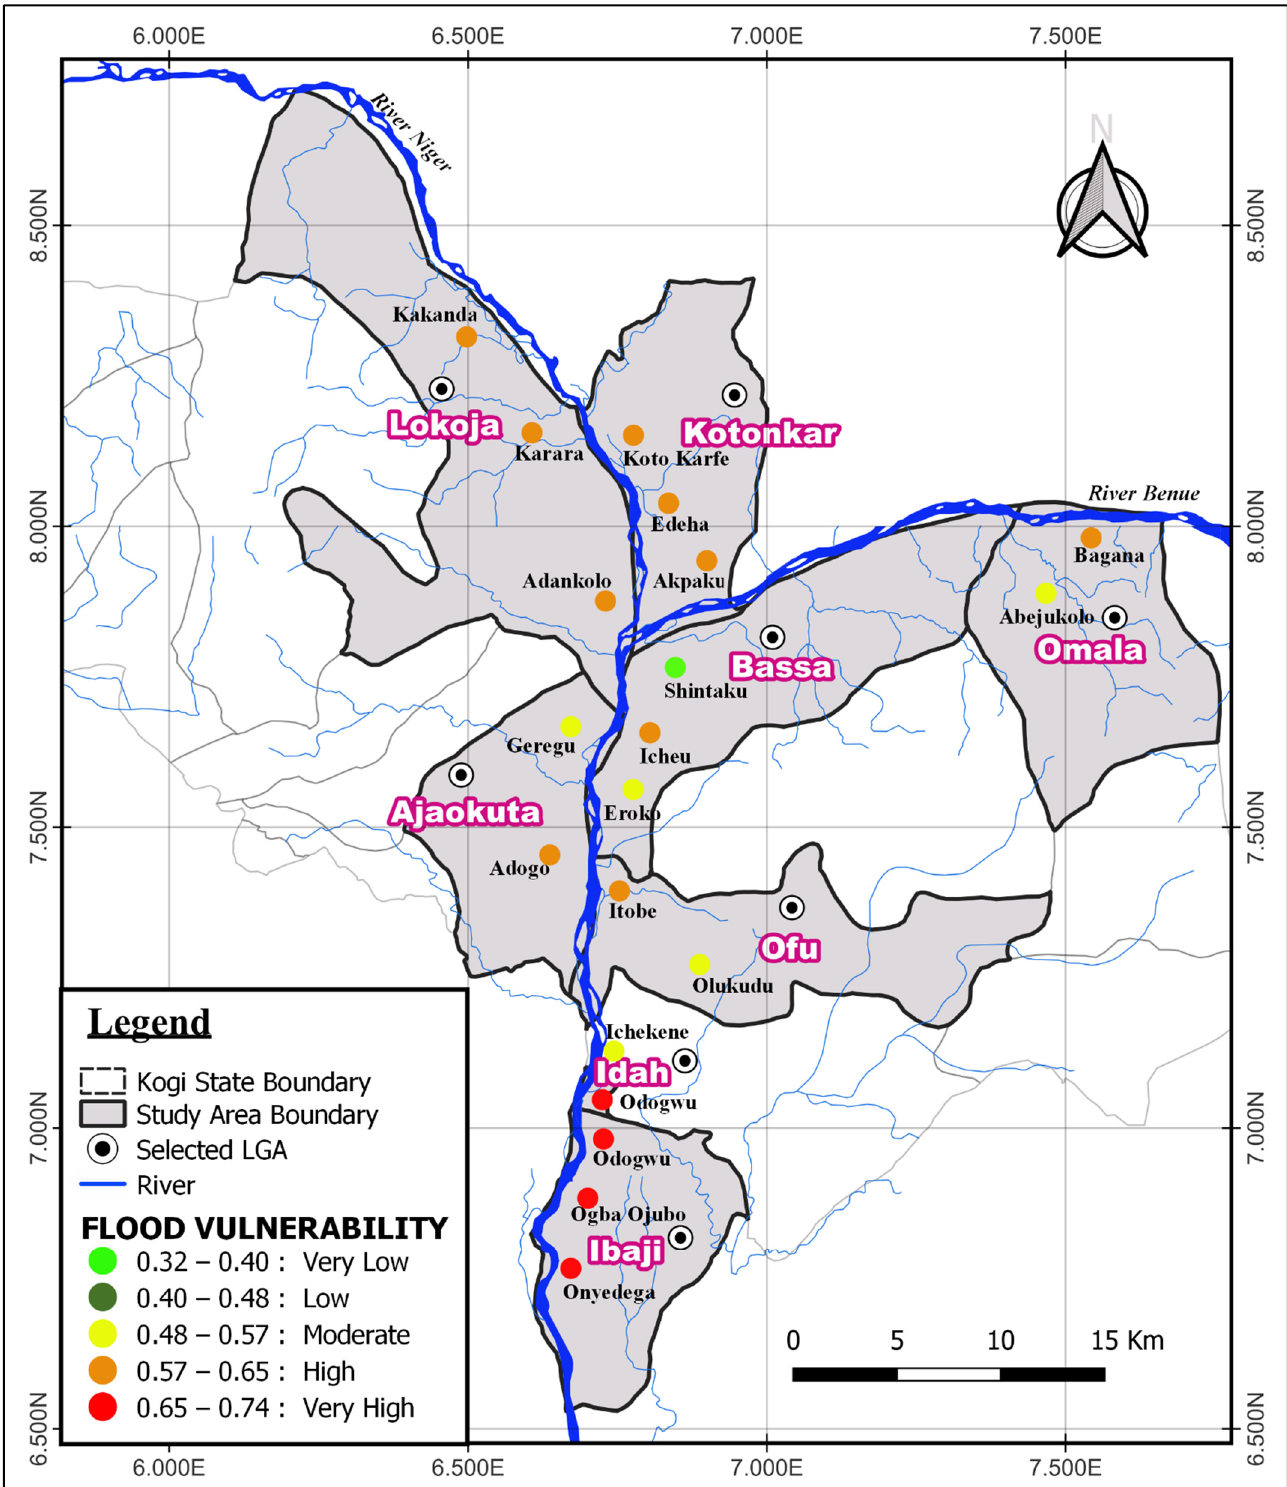
Figure 3. Hotspots of flood vulnerability among the selected communities in Kogi State, Nigeria.